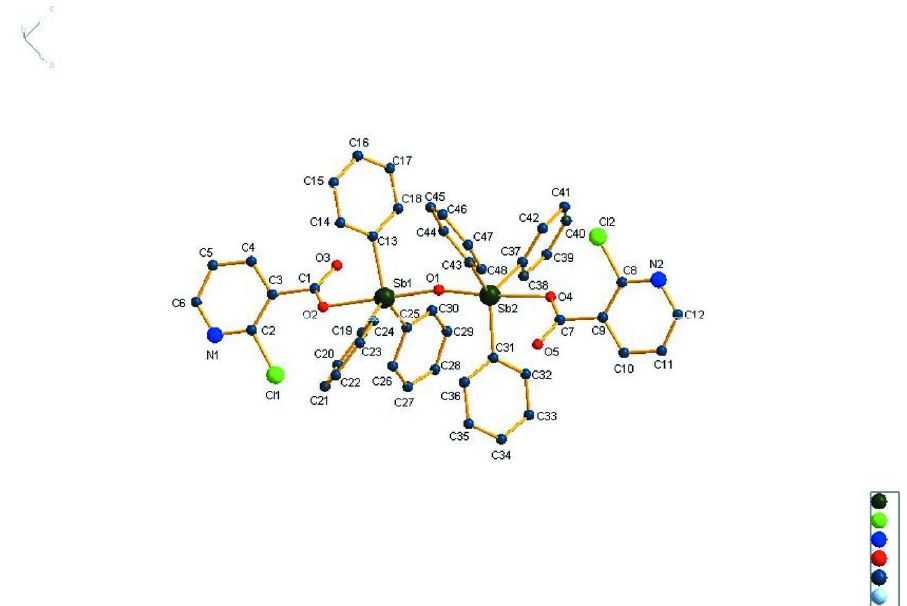
Figure 1 The molecular structure of the title compound, showing displacement ellipsoids at the 30% probability level.